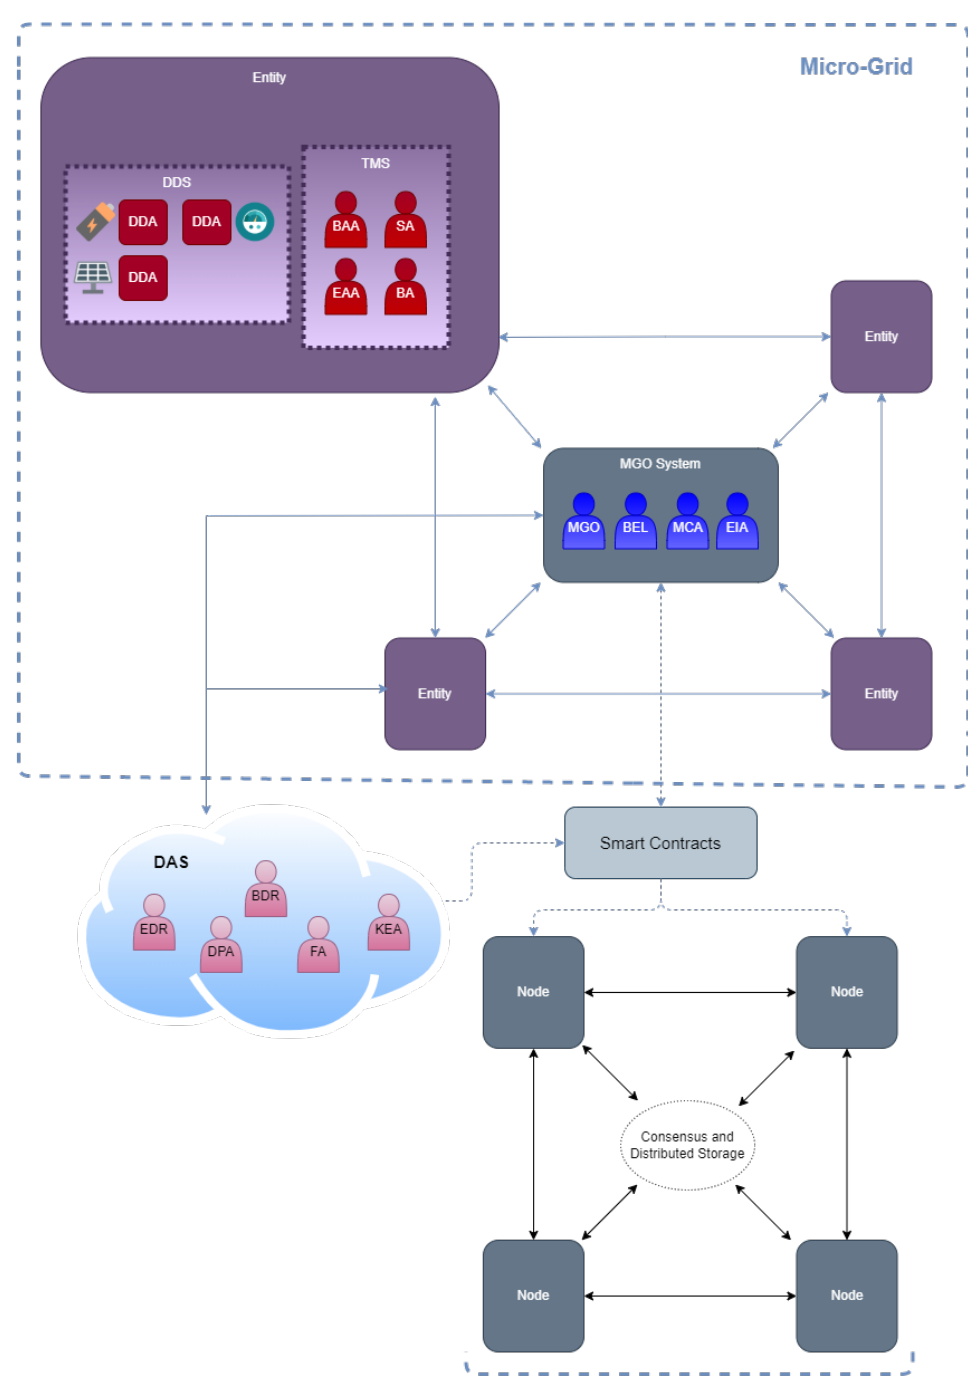
Figure 5. Proposed platform